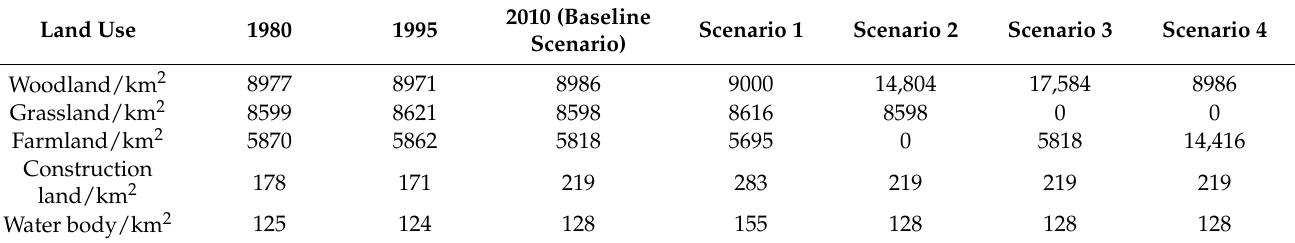
Table 5. Area of land-use type in each scenario.